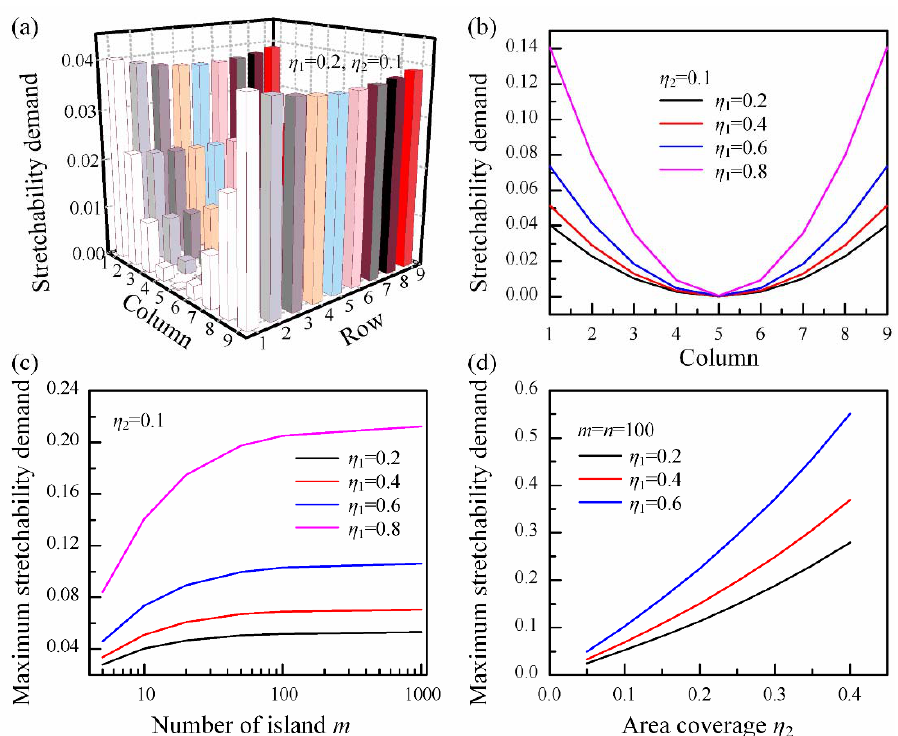
Figure 7. Demands for stretchability of the bridges given by geometric method: location-dependent property of demands for stretchability in the array ( a ) and at the first row ( b ) for the horizontal bridges; maximum demand for stretchability of the device with the number of islands ( c ) and area coverage ( d ).